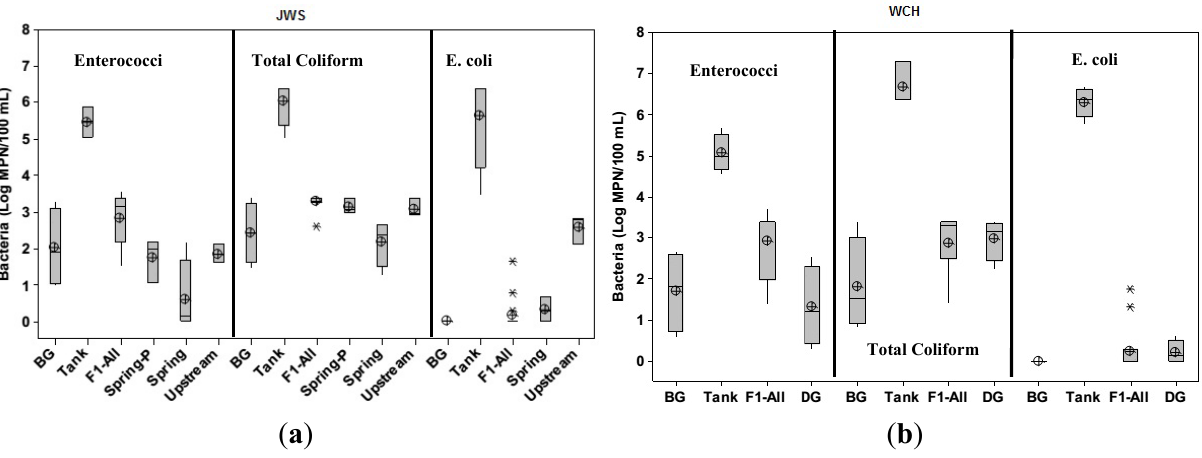
Figure 7. Fecal indicator bacteria concentrations (Log MPN/100 mL) data at James